Question: Author a descriptive caption for the visualization shown.
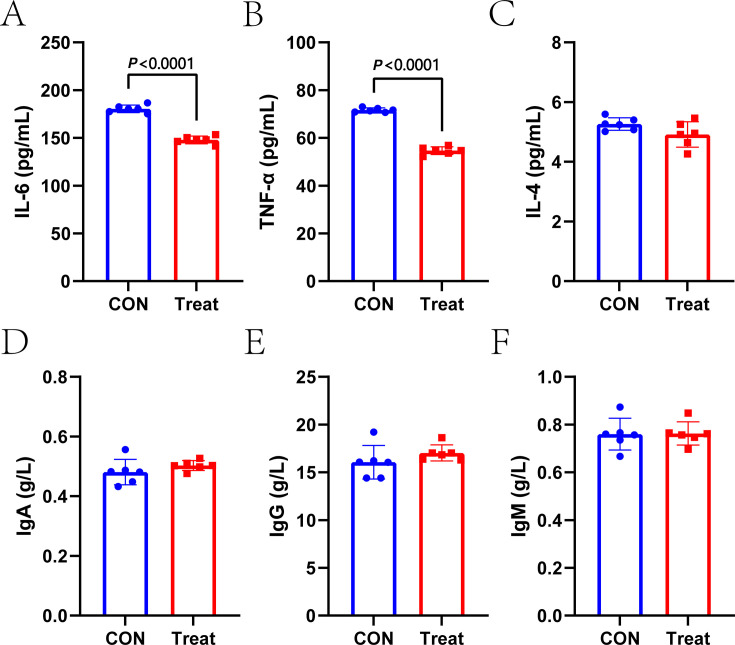
Answer: Effects of supplemental fermented Chinese herbal medicine on serum immune parameters in lambs. Data are presented as mean ± SEM. Group comparisons were analyzed using an independent samples t -test. Bar graphs showing fermented Chinese herbal medicine effects on lamb serum immune parameters. ( A ) IL-6; ( B ) TNF-α; ( C ) IL-4; ( D ) IgA; ( E ) IgG; ( F ) IgM. Treatment significantly reduced inflammatory cytokines IL-6 and TNF-α, while IL-4 and immunoglobulins IgA, IgG, and IgM remained unchanged.